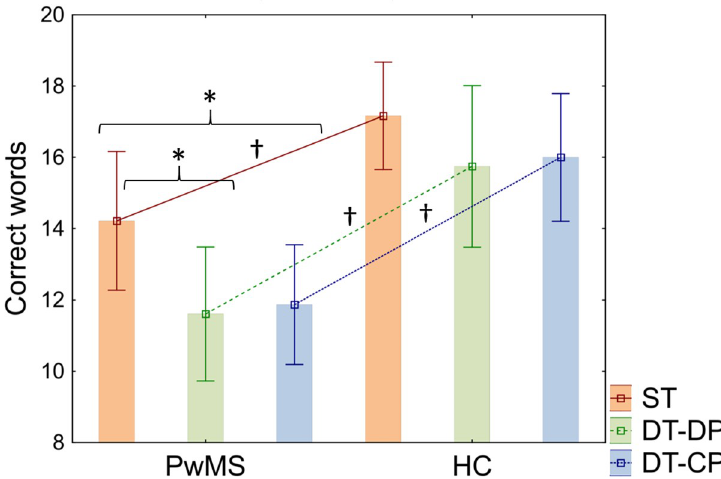
Fig 2. Cognitive-motor interference over cognitive performance. Number of correct words uttered (mean ± standard deviation) during single task (ST), dual task with double priority (DT-DP) and dual task with cognitive priority (DT-CP) by people with multiple sclerosis (pwMS) and healthy controls (HC). Significant contrasts are indicated by the black lines over the graph. � Denotes significant intragroup contrasts -ST vs DT-DP, ST vs DT-CP and DT-DP vs DT-CP- in pwMS and HC, respectively. † Denotes significant between-group contrasts -pwMS vs